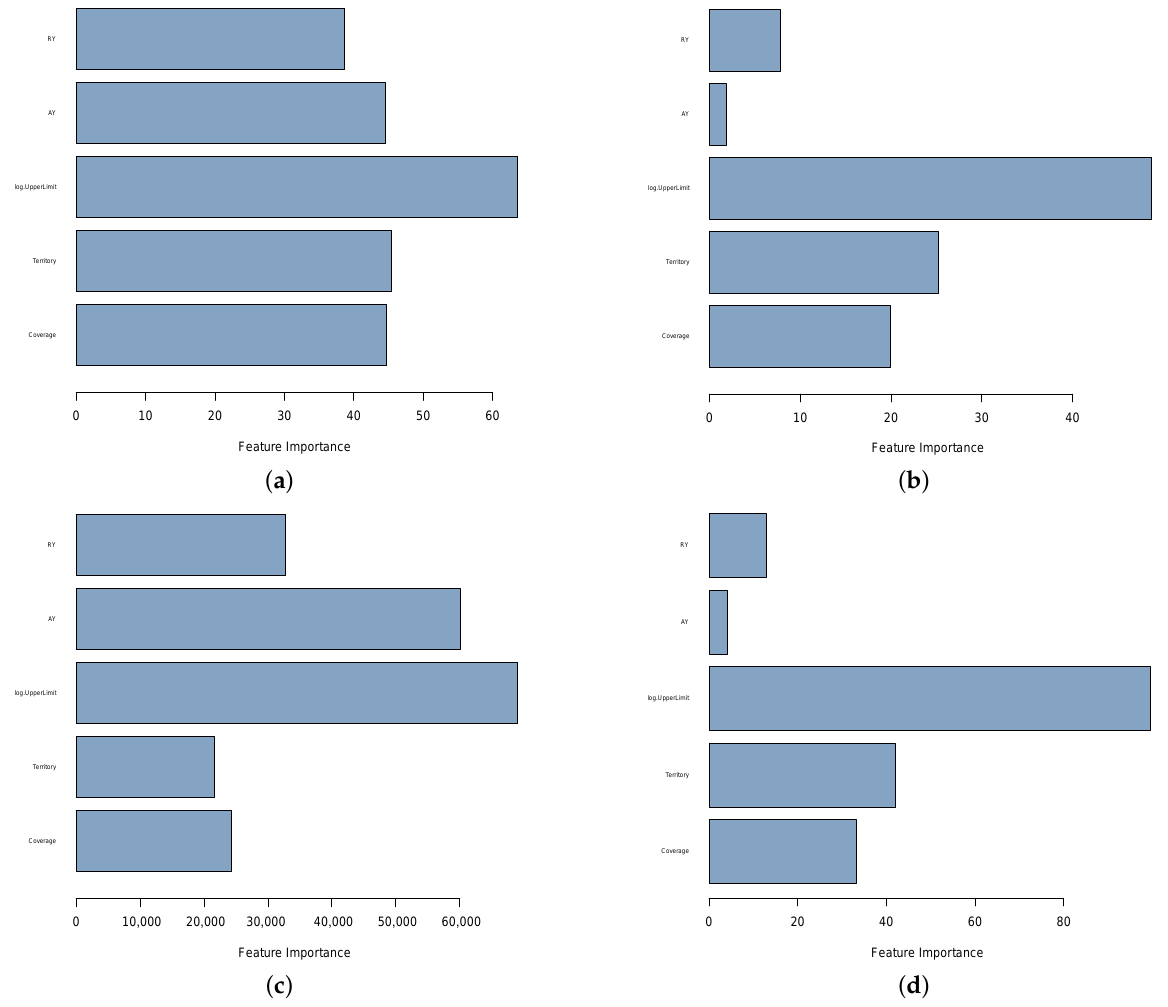
Figure 9. Bar plots for variable importance measures of risk factor in GLM based on the log scale loss amounts using our proposed method. ( a ) Poisson as an error function. ( b ) Gaussian as an error function. ( c ) Gamma as an error function. ( d ) Inverse Gaussian as an error function.